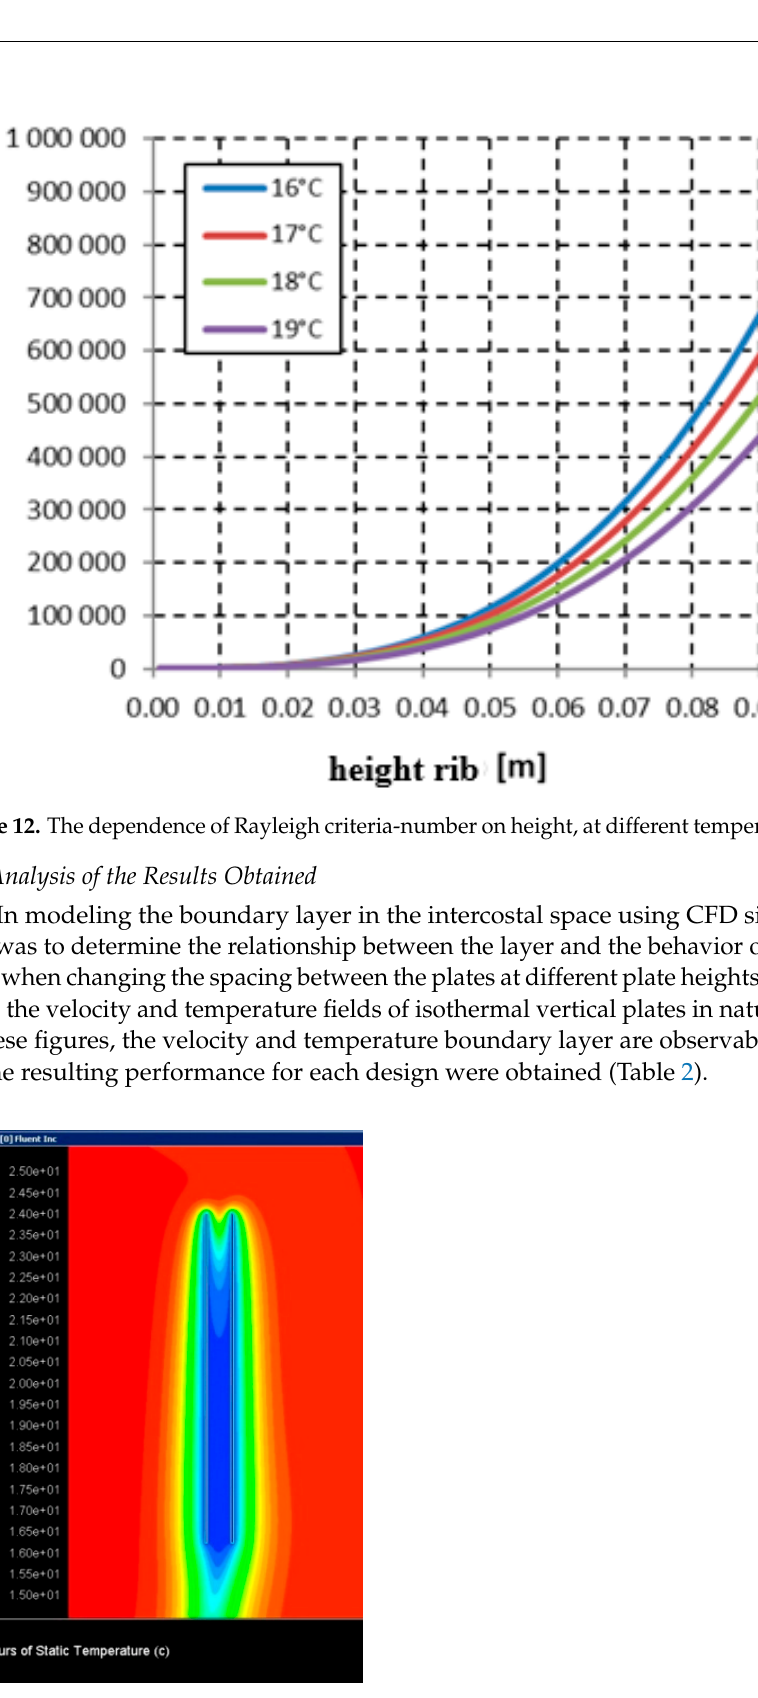
Figure 13. The contours of temperature (°C) at spacing of 5 mm and rib height 70 mm.